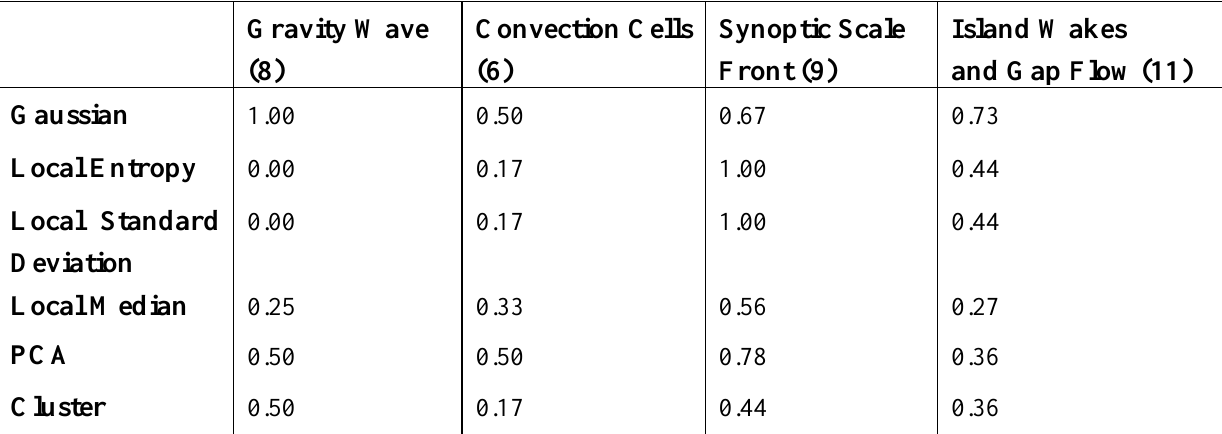
Table 5. Fraction of the occurrences within the 28 case study images for which